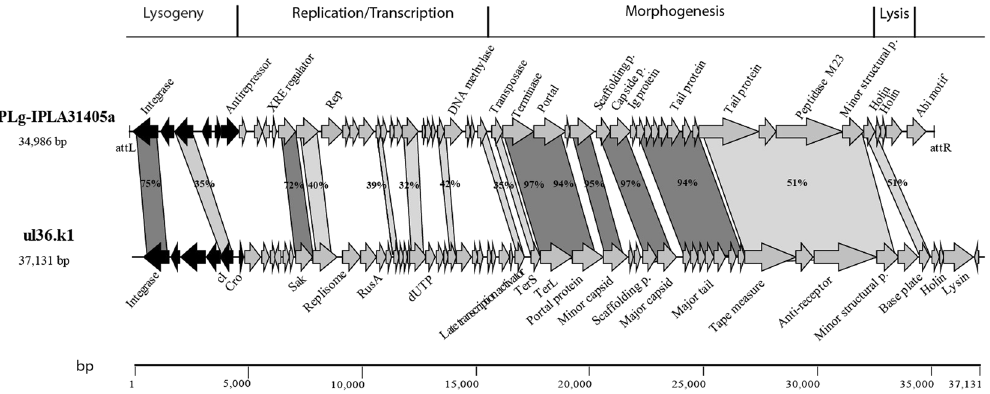
Figure 4. Genomic comparison between L. garvieae phage IPLA31405b and L. lactis phage ul36.k1. Color shading was used to discriminate between ≥ 70% amino acid identity (dark color) and ≤ 69% amino acid identity (light color). The absence of shading indicates no significant similarity. The percent of amino acid identity inside the shading is representative of the aligned region only. Black arrows identify the lysogeny module.